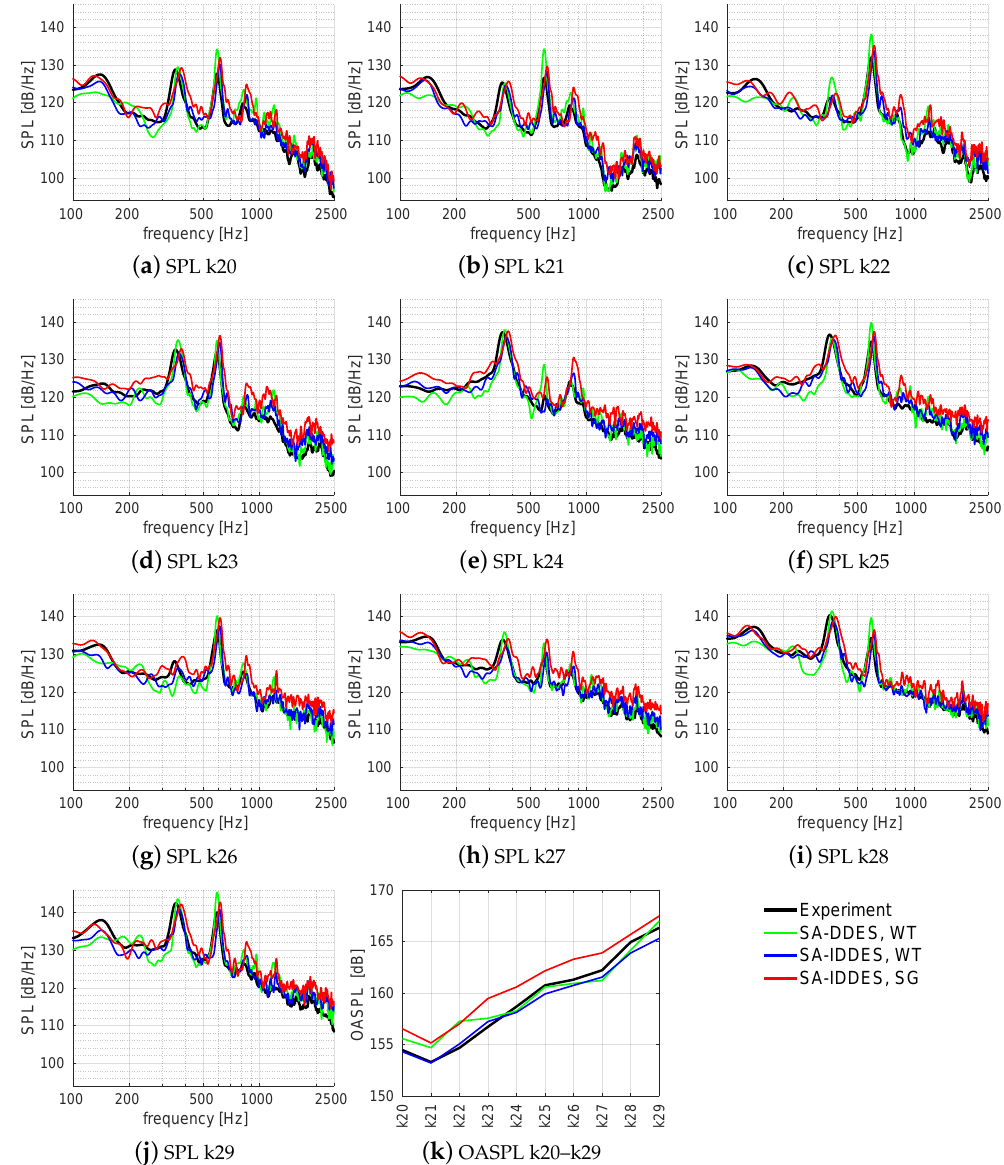
Figure 11. ( a – j ) SPL at probes k20–k29. ( k ) OASPL at probes k20–k29. Here, WT and SG denote the wind tunnel model and simplified geometry,